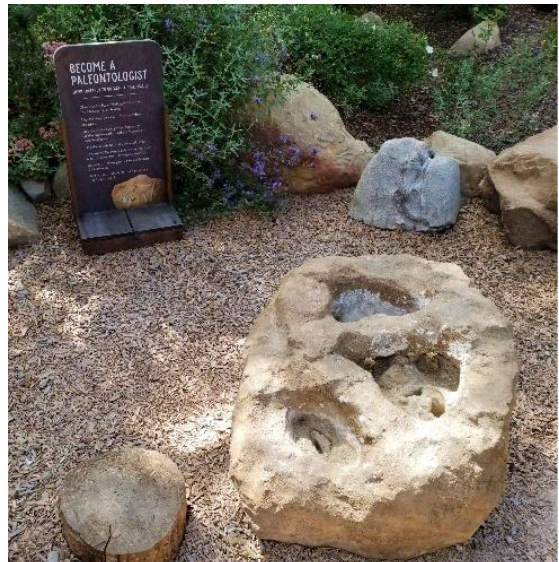
Figure 6. Build area.